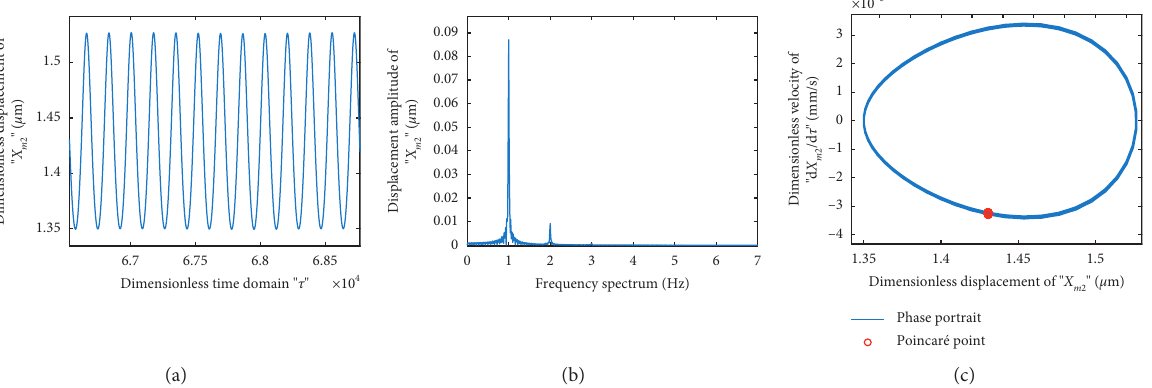
Figure 11: The dynamic response of system X m 1 at 10930rpm. (a) Time-domain response. (b) FFTspectrum. (c) Phase plane and Poincar´e point.